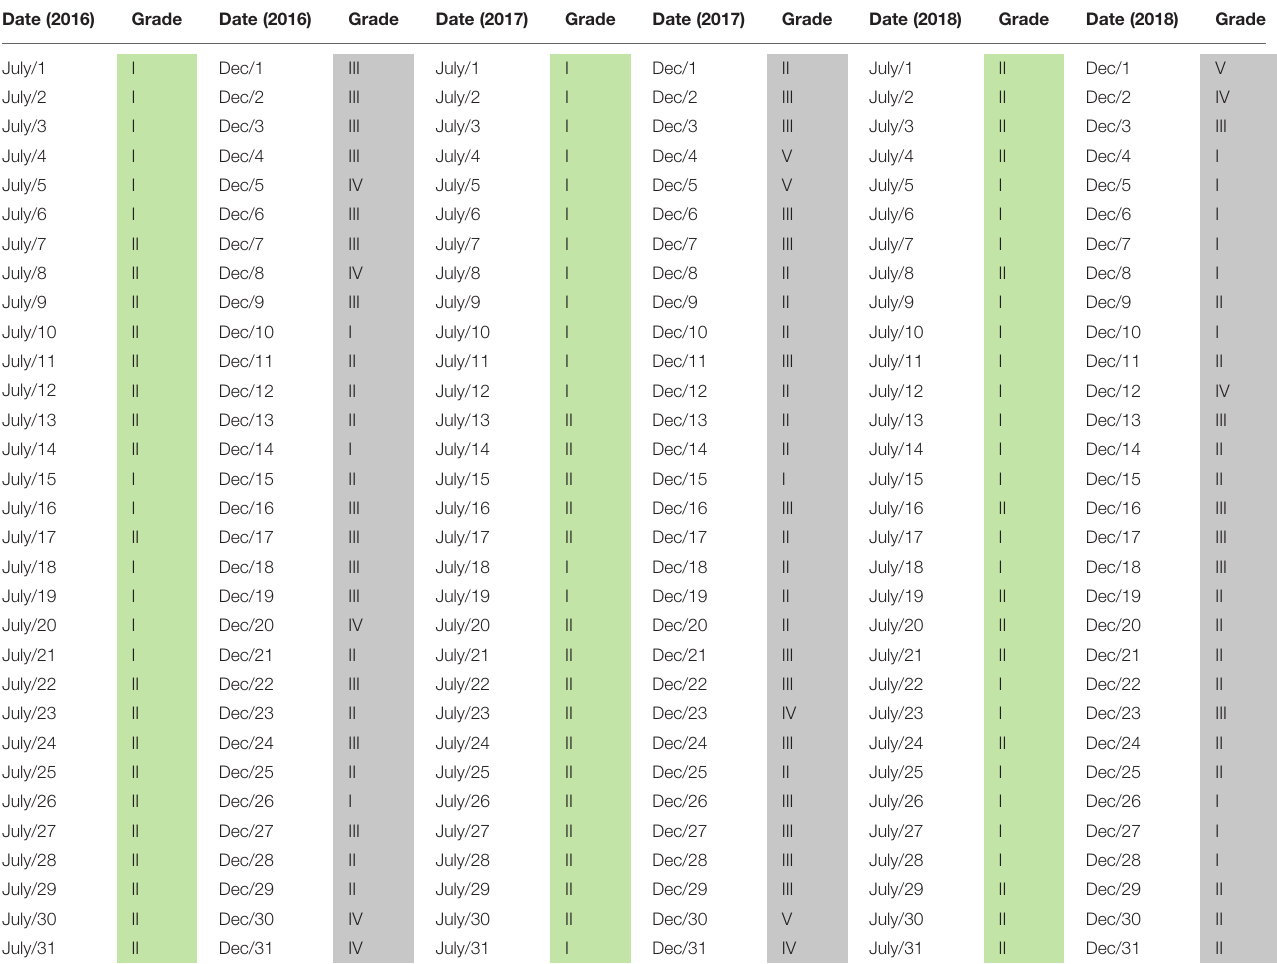
TABLE 5 | Daily grade results based on Improved Double-weighted Fuzzy Comprehensive Evaluation (ID-FCE; December and July of